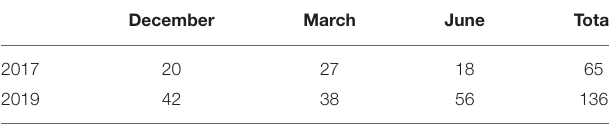
TABLE 2 | Examples of prices of common items in the college catering budget. Food